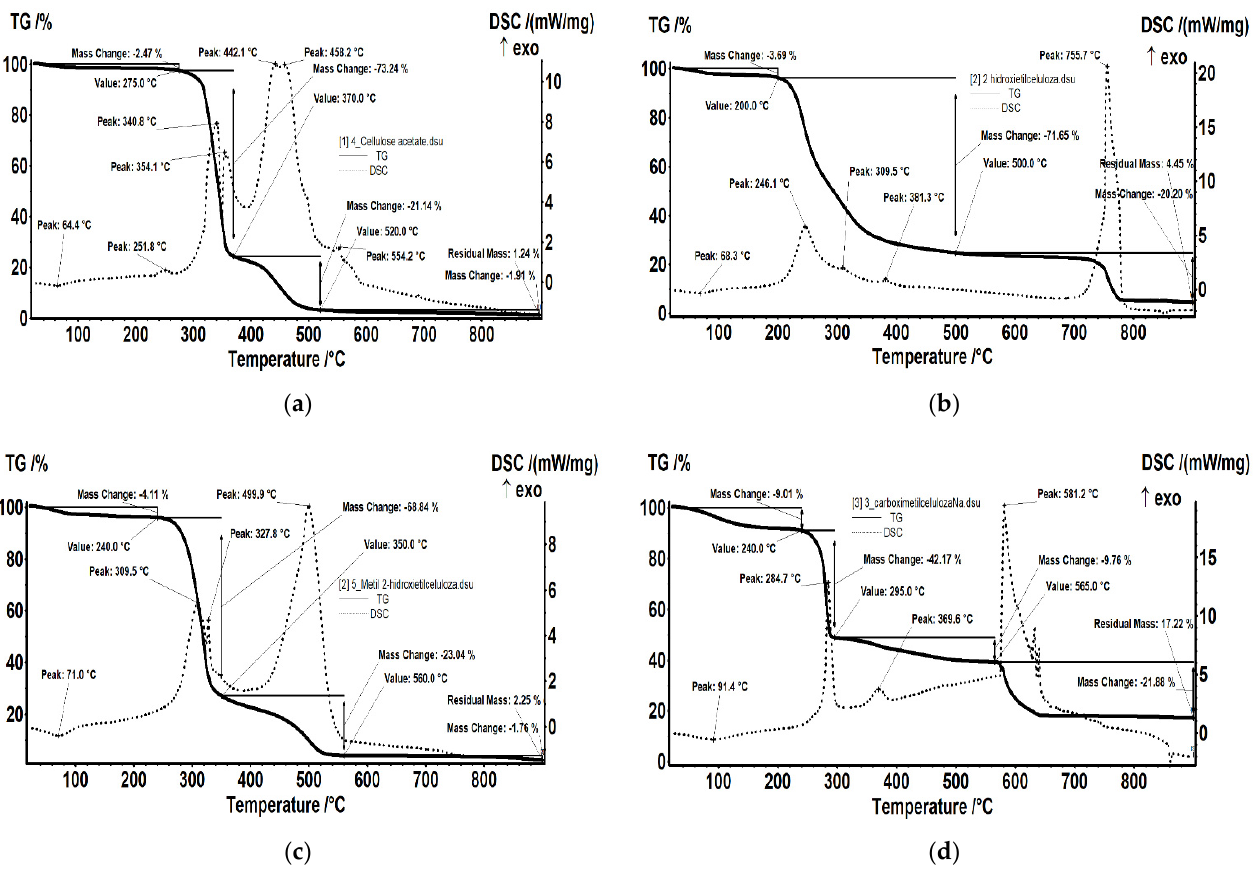
Figure 5. Thermal diagrams for: ( a ) cellulose acetate (CA); ( b ) 2–hydroxyethyl cellulose (HEC); ( c ) methyl 2–hydroxyethyl– cellulose (MHEC); ( d ) sodium carboxymethyl–cellulose (NaCMC).